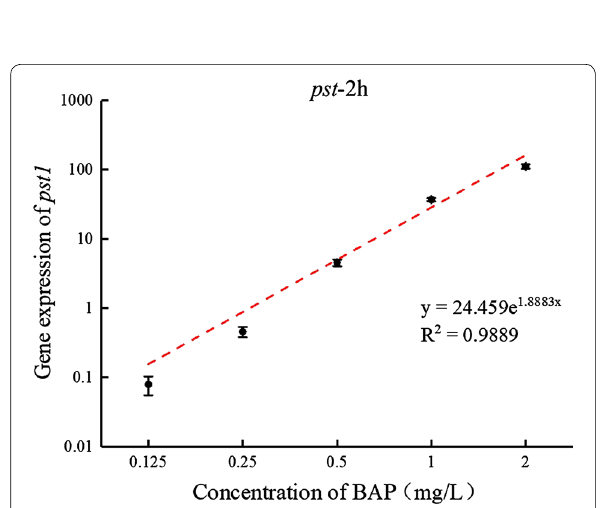
Fig. 4 Standard curve based on the mRNA expression of pst1 -2 h in different concentrations of phosphorus (K 2 HPO 4 )